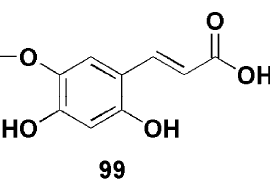
Figure 27. Structure of compound 99